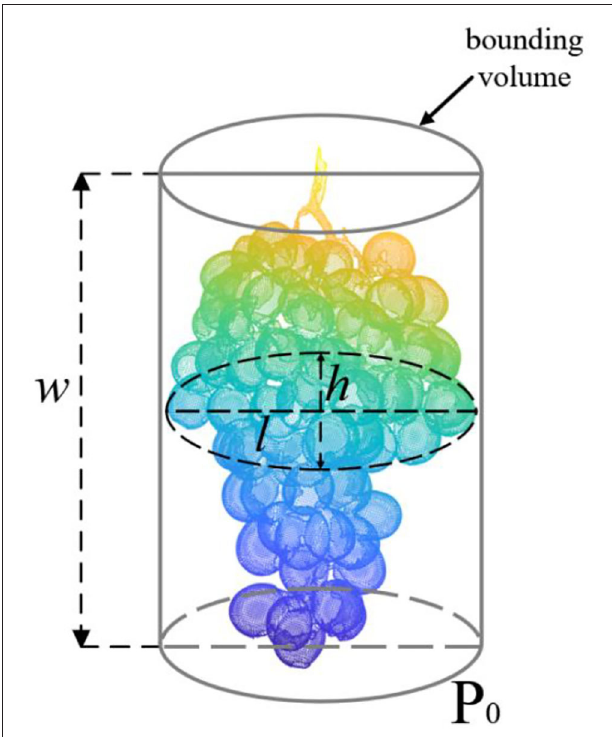
FIGURE 8 | Schematic diagram of the length, height, and width measurement parameters of the grape model. The gray cylinder is a geometric bounding of the grape